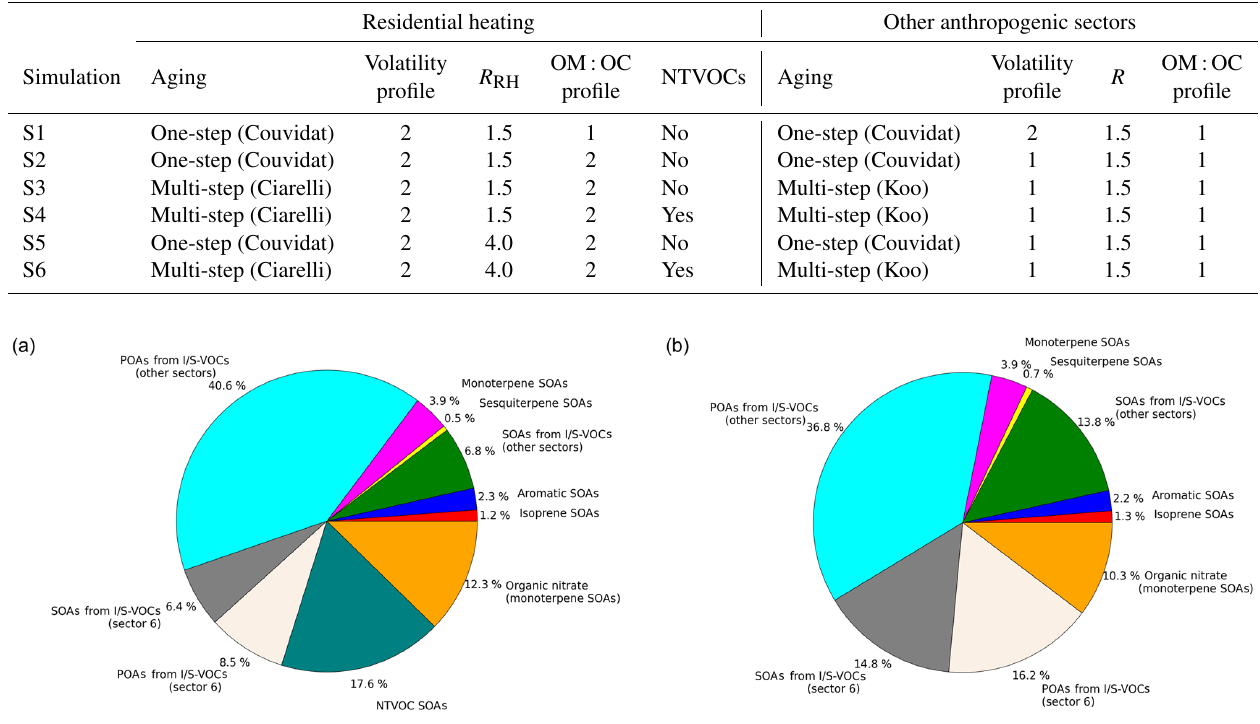
Figure 2. Simulated composition of OM 1 during the winter campaign of 2014 for two simulations: S4 (a) and S5 (b) .